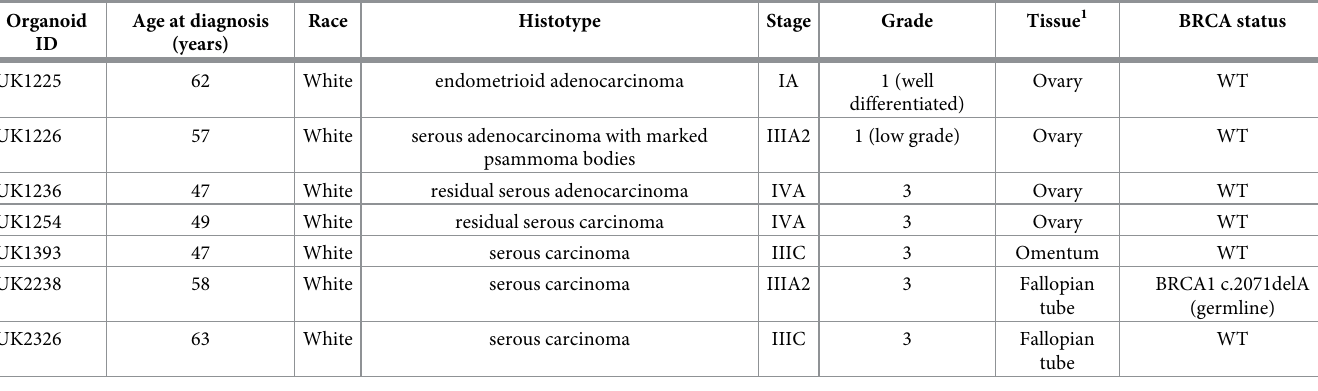
Table 1. Clinical information for organoid tissue